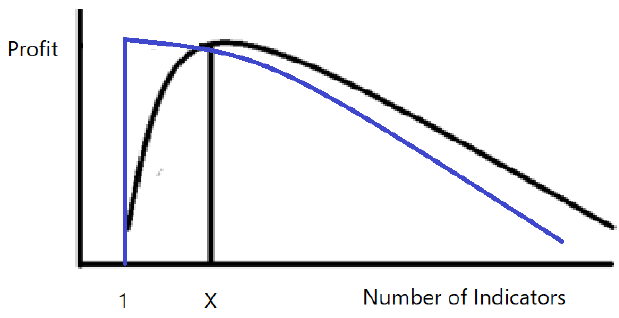
Figure 1. Profits and the number of technical indicators.